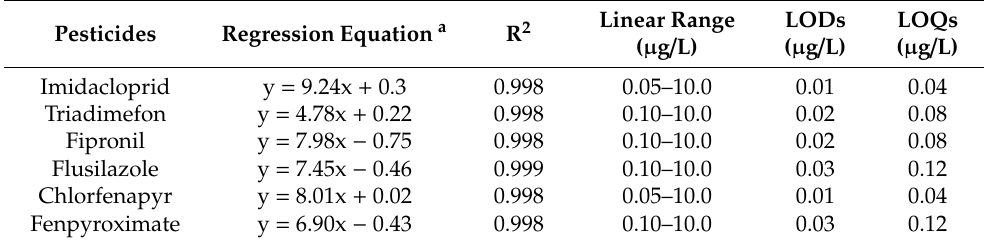
Table 1. Linear regression equations, correlation coe ffi cients, LODs and LOQs for the six heterocyclic pesticides.